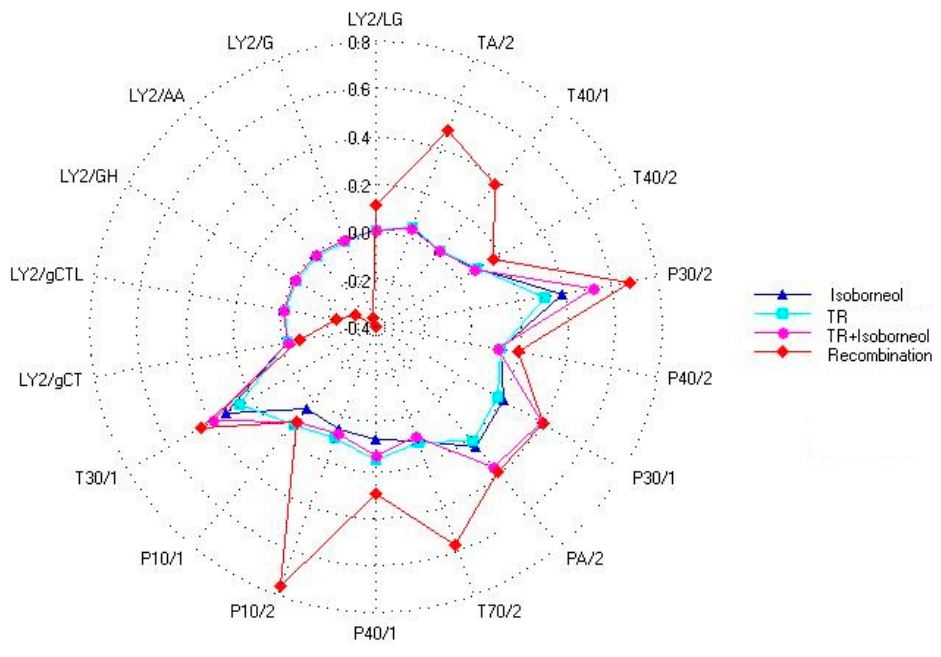
Figure 8. Radar Graph of four samples by e-nose.